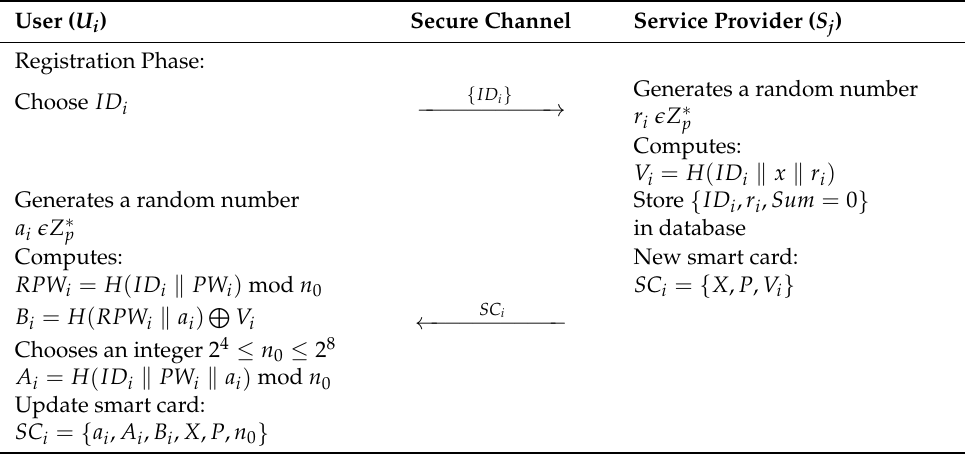
Table 3. User registration